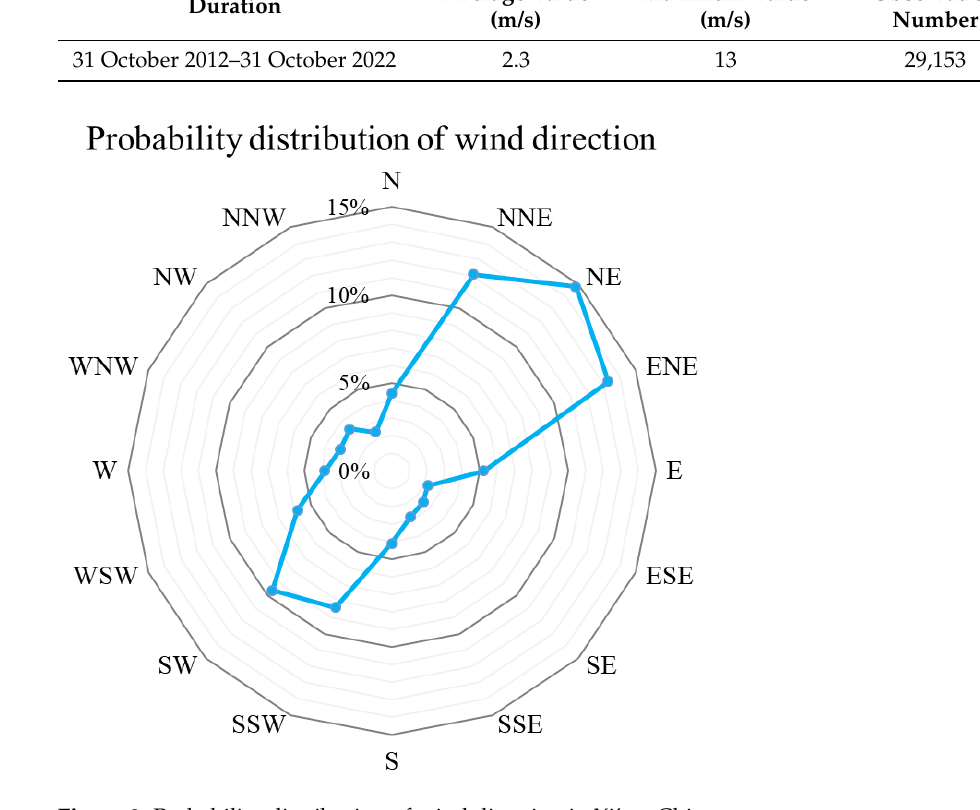
Table 1. Wind speed measurement in Xi’an, 2012–2022.